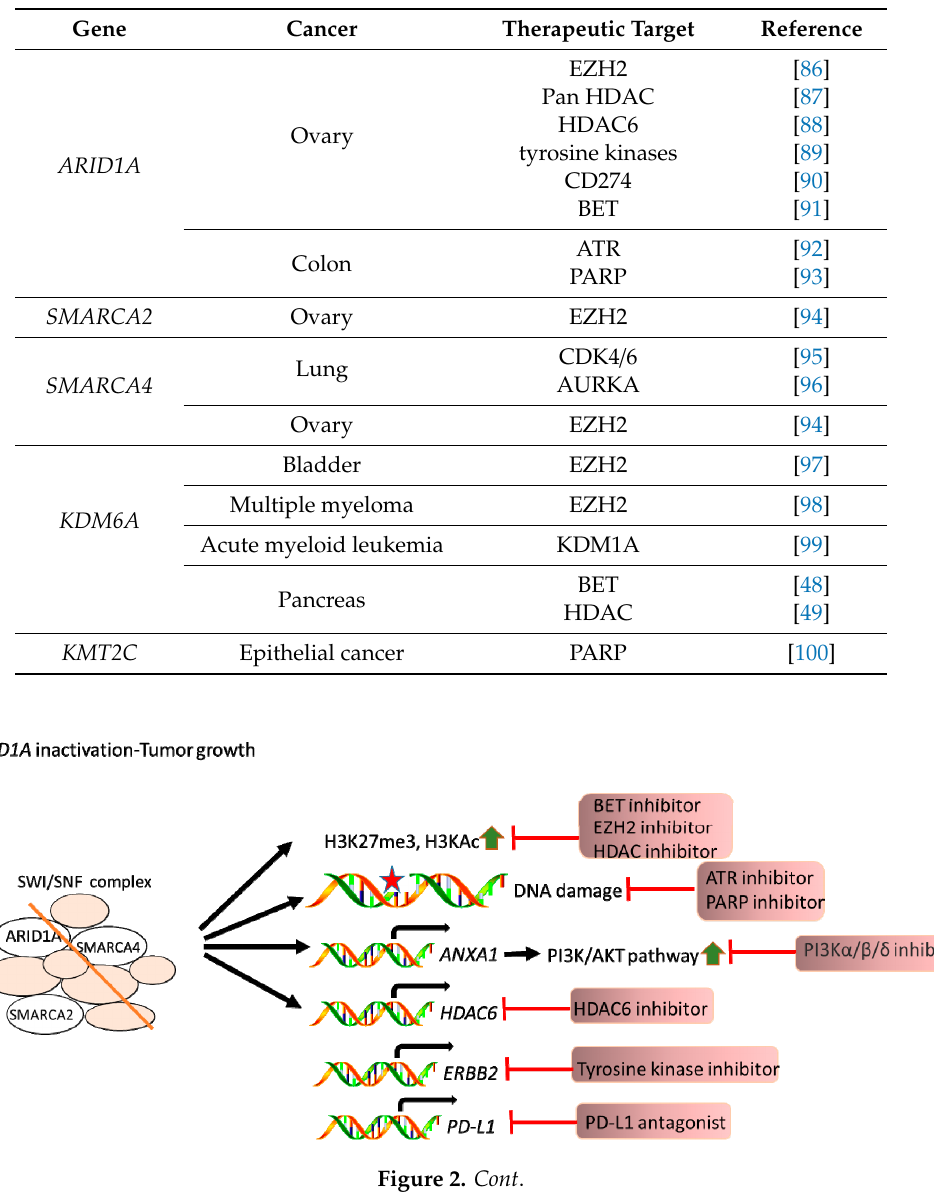
Table 3. Therapeutic targets in cancers with alterations in ARID1A, SMARCA2, SMARCA4, KDM6A, KMT2C, or KMT2D .